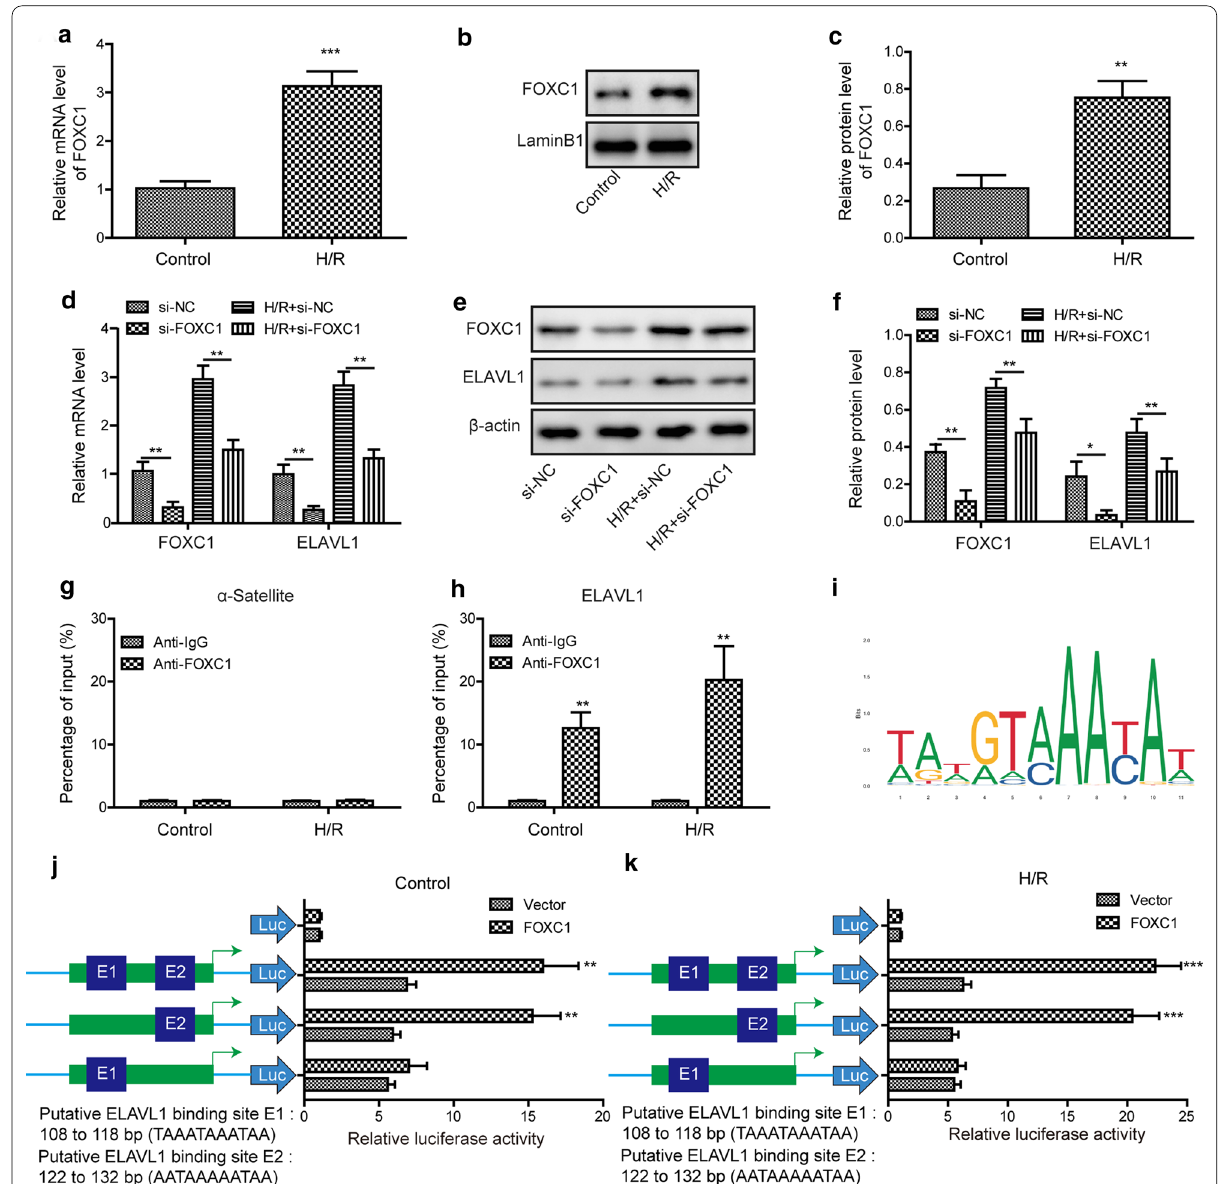
Fig. 7 FOXC1 activates ELAVL1 during H/R. a – c Relative mRNA and protein levels of FOXC1 in cells upon control or H/R exposure. d – f Relative mRNA and protein levels of FOXC1 and ELAVL1 in si‑FOXC1 transfected cells following H/R. g Relative α‑Satellite level pulled down by FOXC1 antibody or control IgG antibody during control or H/R. h Relative ELAVL1 level pulled down by FOXC1 antibody or control IgG antibody during control or H/R. i FOXC1 binding motif provided by the JASPAR database. j Relative luciferase activities of empty vectors or vectors containing E1, E2, or both under baseline. k Relative luciferase activities of empty vectors or vectors containing E1, E2, or both following H/R exposure. The results were presented as the mean SD. n 3; * P < 0.05, ** P < 0.01, *** P < ± =